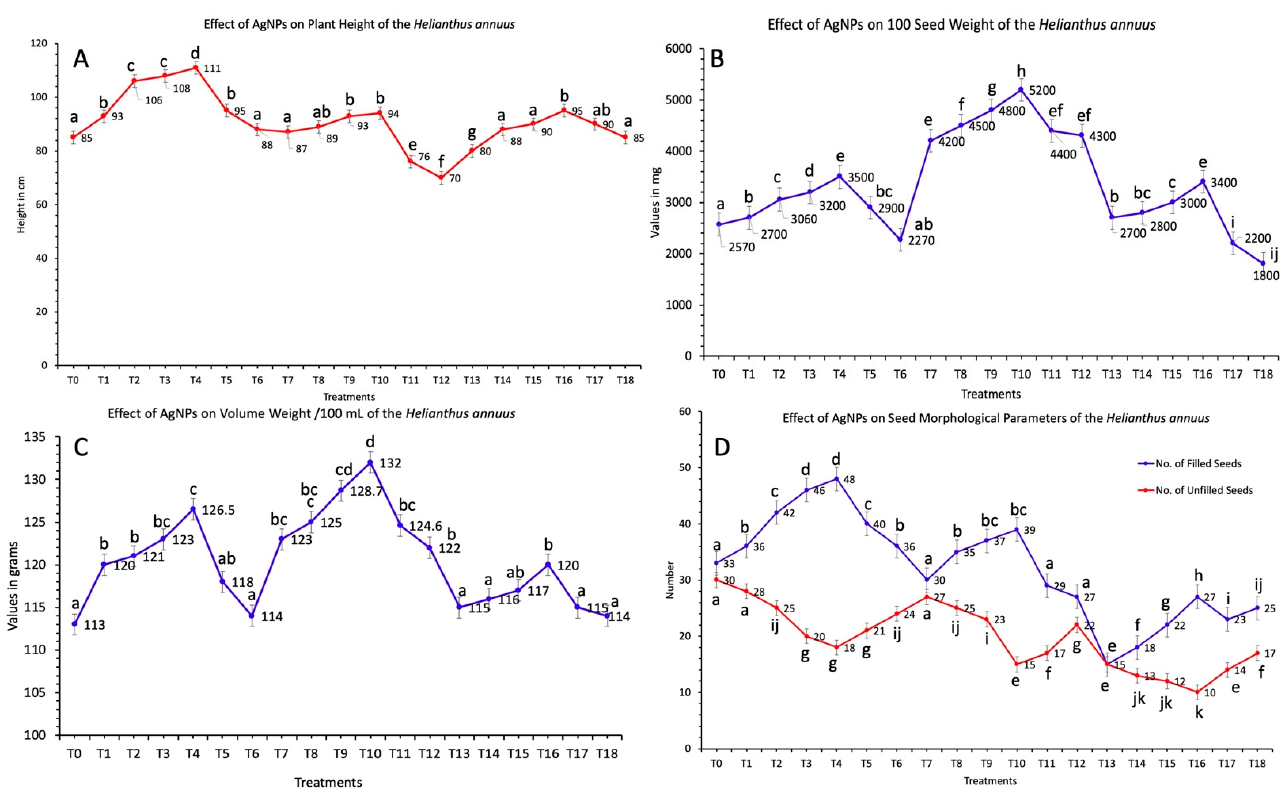
Figure 2. Effects of different treatments of AgNPs on ( A ) plant height, ( B ) 100 seed weight, ( C ) seed volume weight per 100 milliliters and ( D ) number of filled and unfilled seeds. Lowercase letters differed significantly at 5% probability levels, using Duncan’s Multiple Range Test ( p < 0.05).